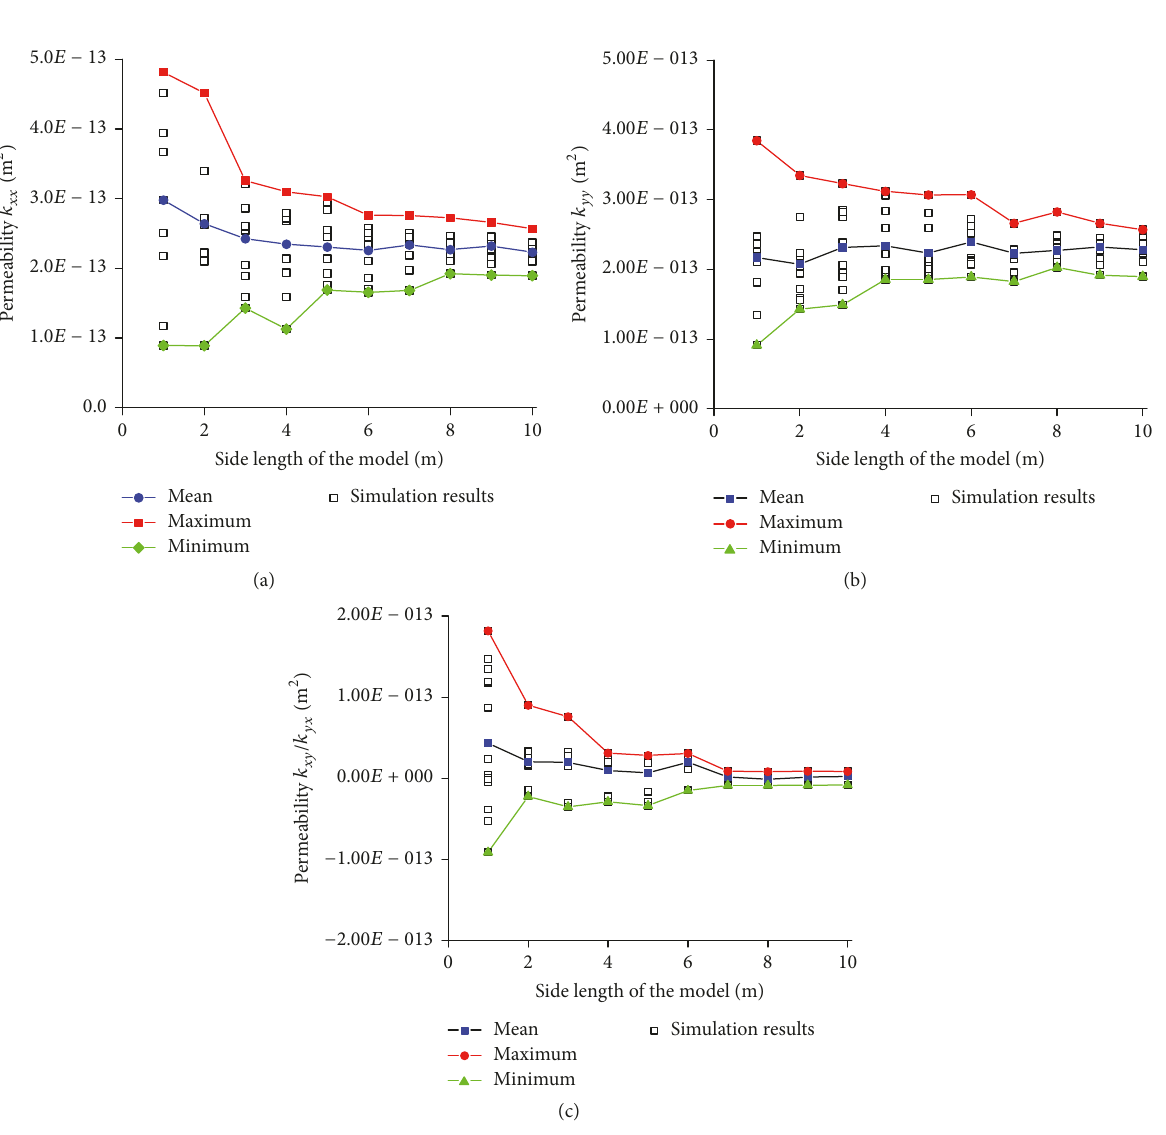
Figure 23: The results, Max, Min, and mean of calculated intrinsic permeability components in the non-Darcy flow. (a) 𝑘 𝑥𝑥 , (b) 𝑘 𝑦𝑦 , (c) 𝑘 𝑘 𝑥𝑦 , and 𝑦𝑥